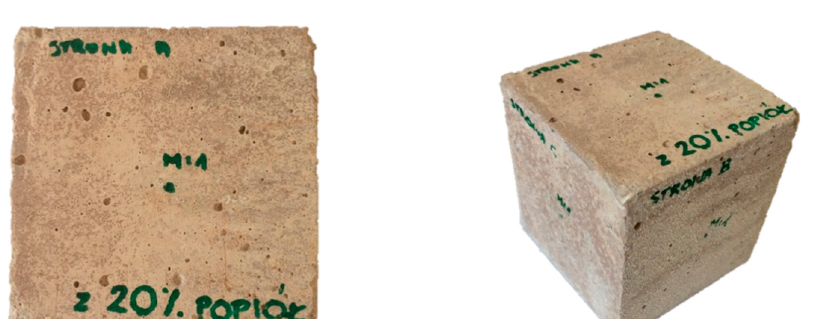
Figure 2. Ordinary concrete cube.